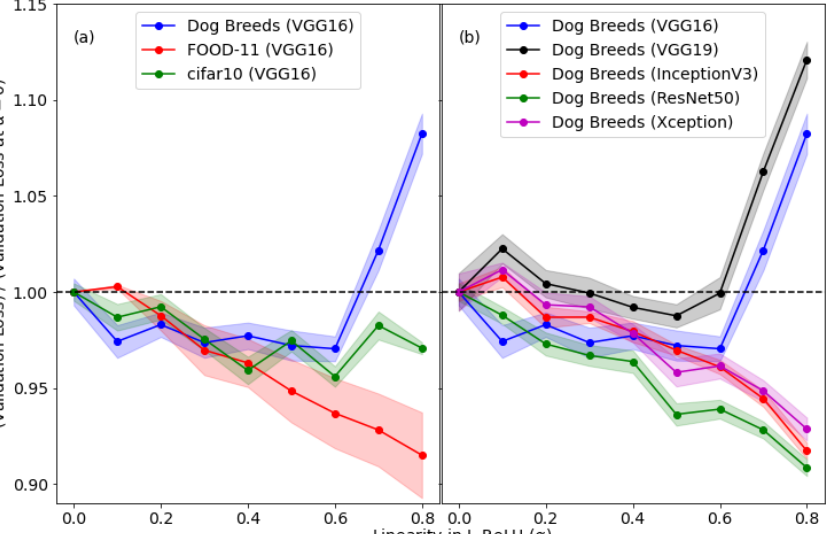
Figure 4. ( a ) Validation loss with respect to the validation loss at α = 0 as a function of linearity factor ( α ) for Dog Breeds, FOOD-11 and cifar10 data sets modeled using VGG16 pre-trained model, ( b ) validation loss with respect to the validation loss at α = 0 as a function of linearity factor ( α ) for Dog Breeds data using VGG16, VGG19, InceptionV3, ResNet50 and Xception pre-trained models. For each curve, width of the band shows the uncertainty due to different weight initialization in classification